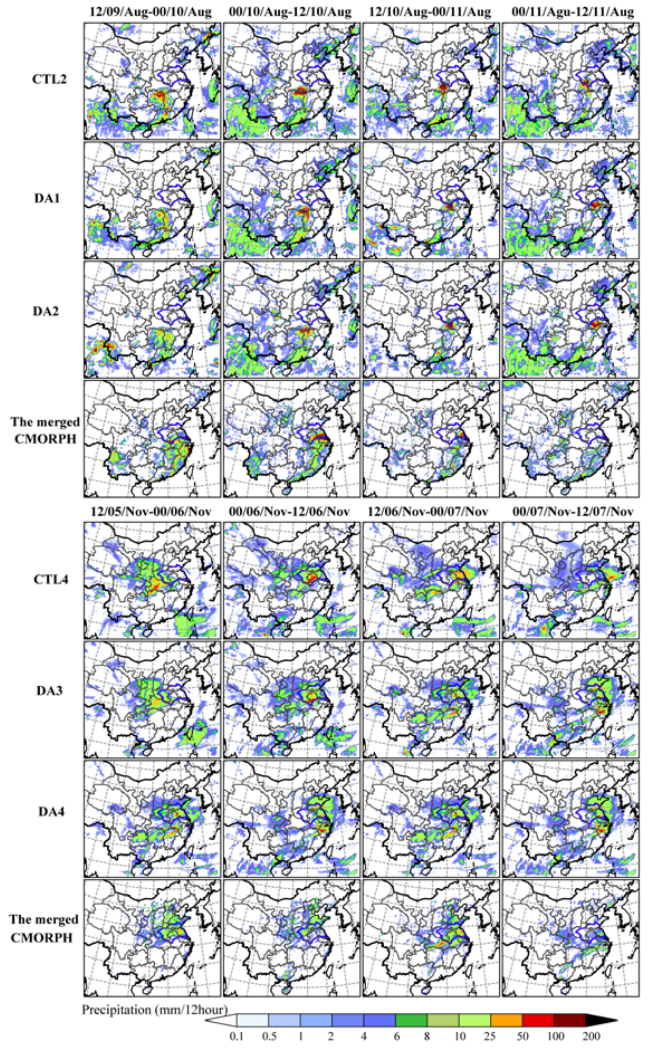
Figure 5. Spatial patterns of 12-hour accumulated precipitation obtained from experiments CTL2, CTL4, DA1-4, and the merged CMORPH estimations over a subset of